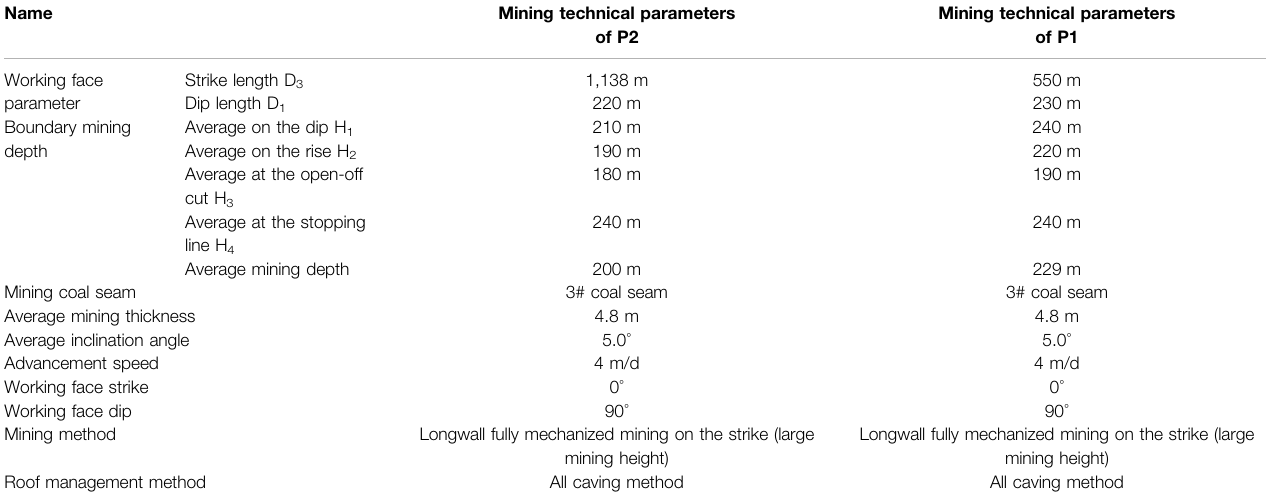
TABLE 2 | Mining technical parameters of the fully mechanized caving faces P2 and